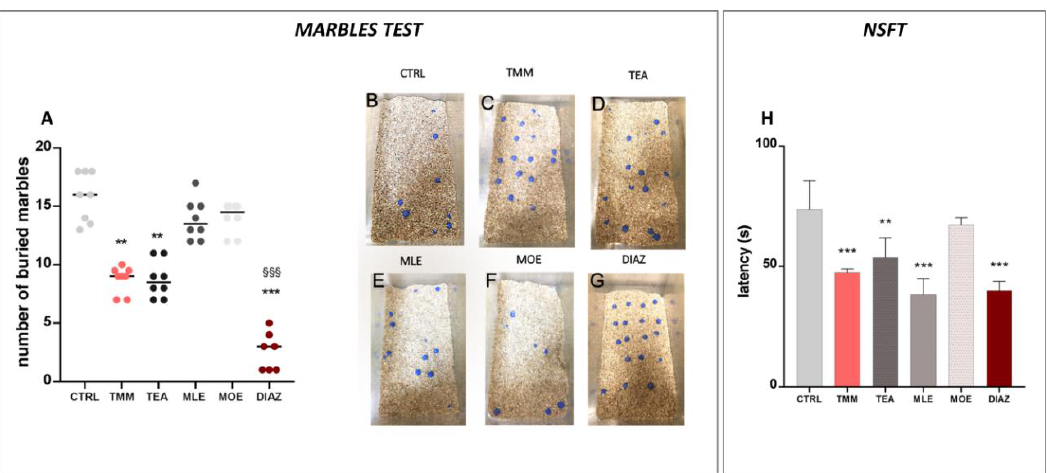
Figure 2. Effects of TMM (10 mg/kg), TEA (2.5 mg/kg), MLE (0.625 mg/kg), and MOE (0.25 mg/kg) in the marbles test ( A ), with representative images ( B – G ) and novelty suppressed feeding test (NSFT) ( H ). DIAZ was used as a positive control. *** p < 0.001, ** p < 0.01, * p < 0.05 vs. CTRL; §§§ p < 0.001 vs. TMM.